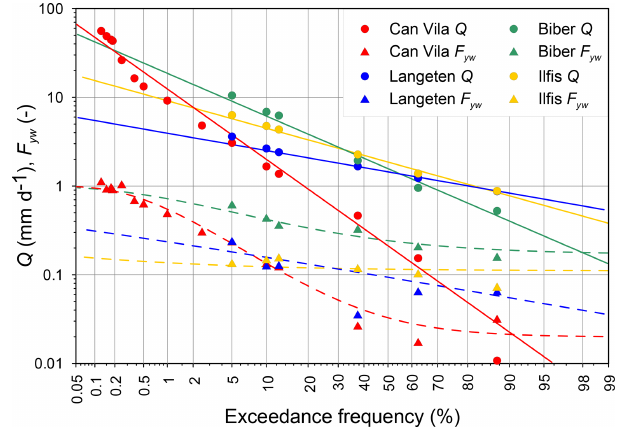
Figure 5. Discharges and young water fractions from Fig. 3 plot- ted against the respective quantile frequencies, along with the log- normal distributions fitted to discharges (solid lines) and distribu- tions of young water fractions (dashed curves) obtained by applying Eq.